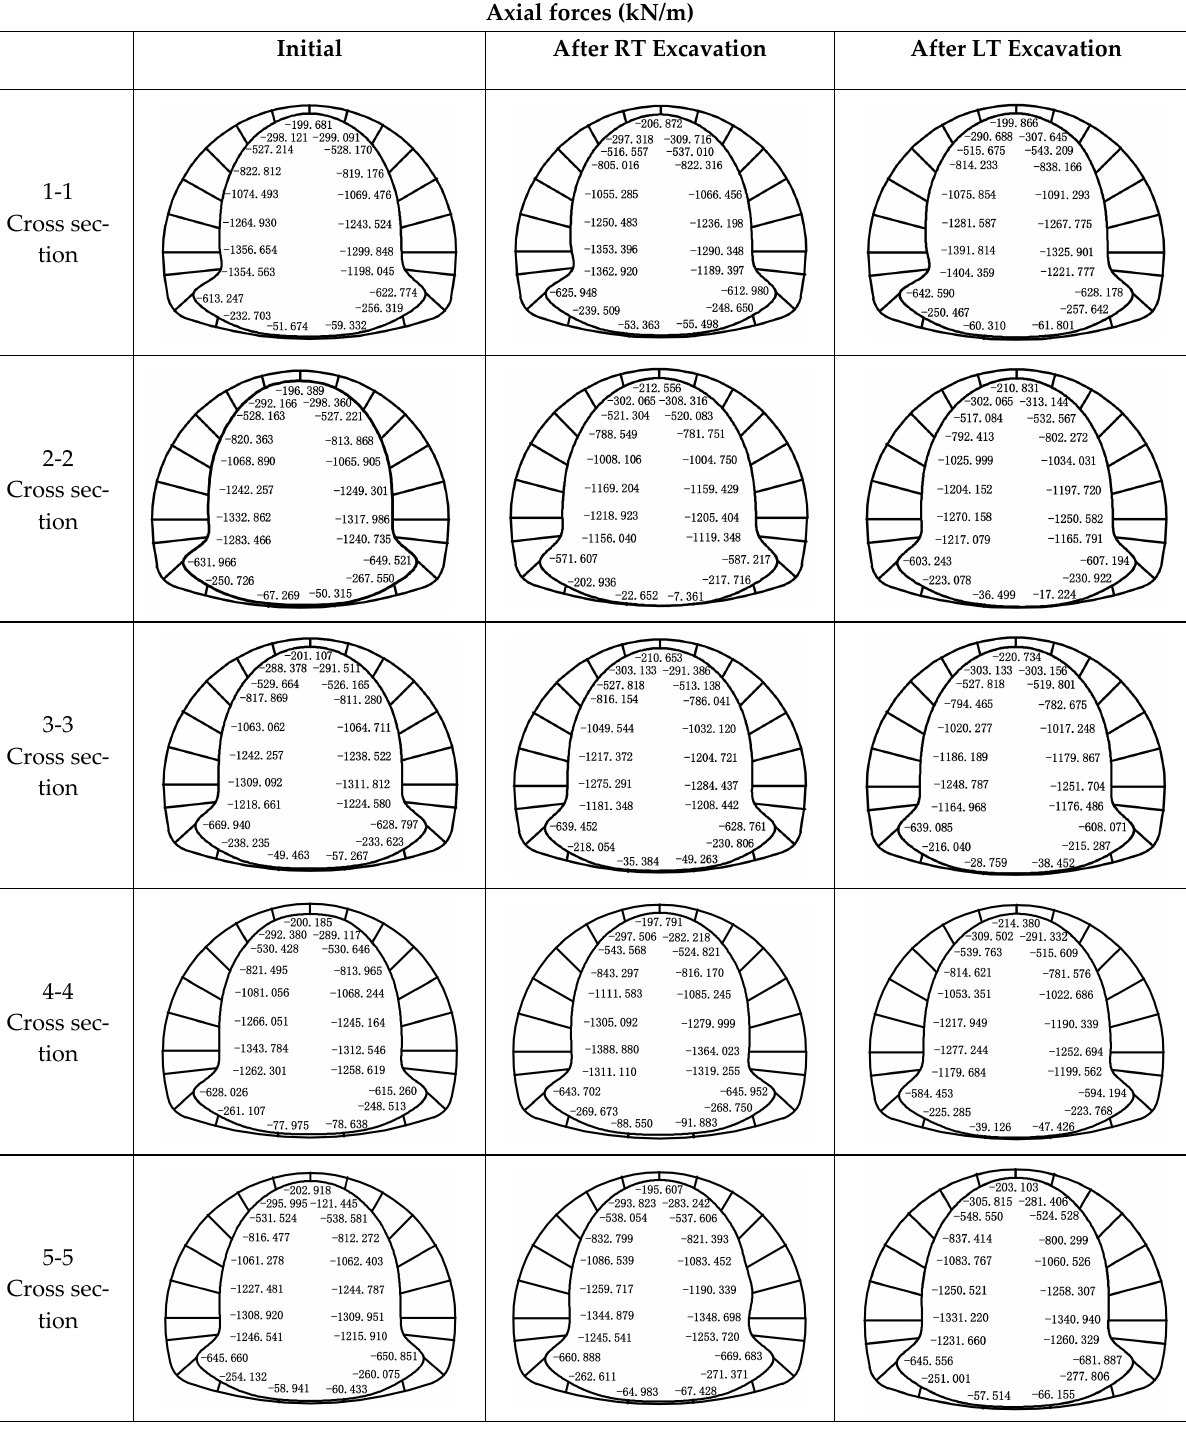
Figure 12. Axial forces and bending moment diagram of the existing tunnel section. After the RT excavation, the axial forces and bending moments corresponding to each cross ‐ section changed due to the transverse deformation produced. The positive bending moment values generated at the left and right arch foot of section 2 ‐ 2 were larger, the maximum variation value at the right arch foot was 5.4209 kN.m/m, and the negative